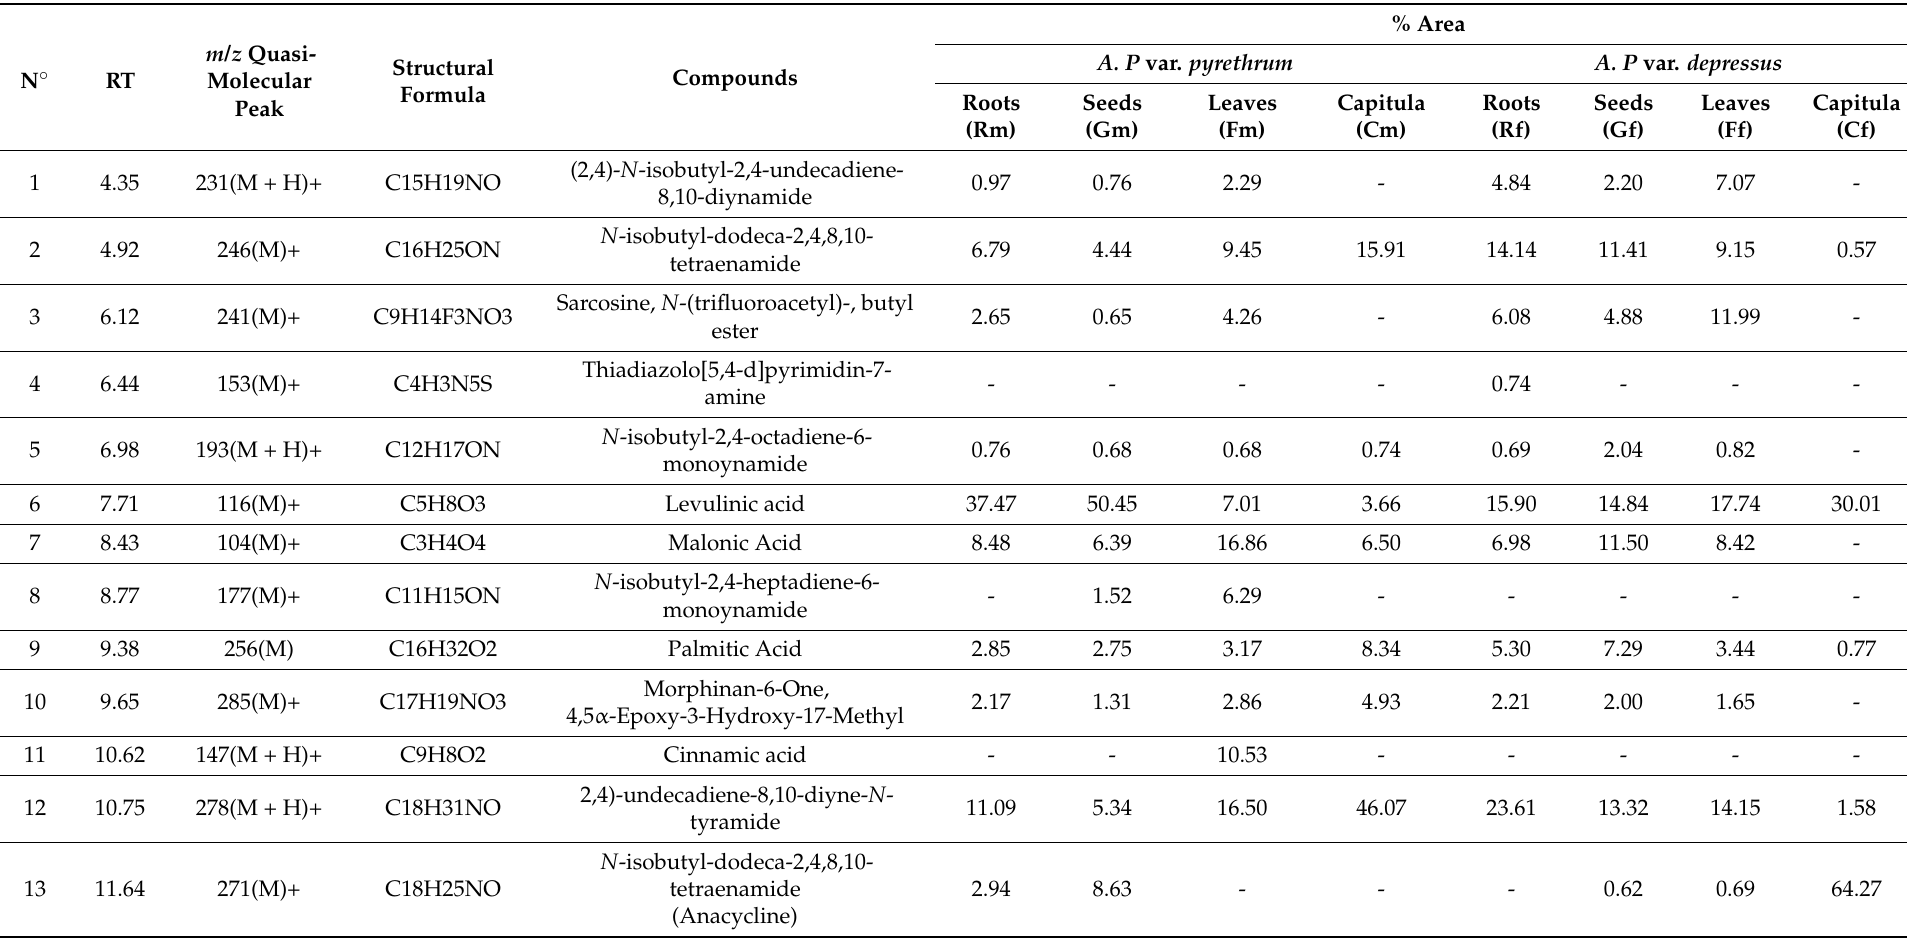
Table 2. Chemical compositions of different parts (roots, seeds, leaves, and capitula) of the two varieties Anacyclus pyrethrum var. pyrethrum (L.) and Anacyclus pyrethrum var. depressus